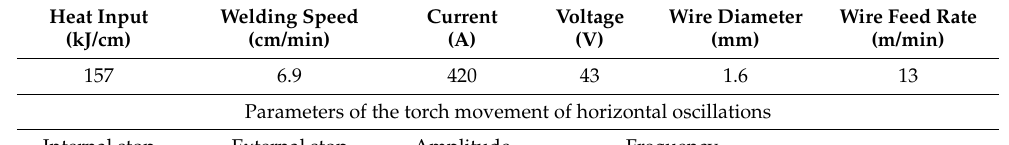
Table 1. Parameters of welding experiments.